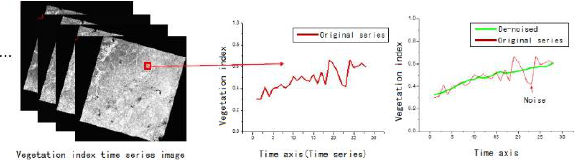
Figure 2. Time series analysis of vegetation index